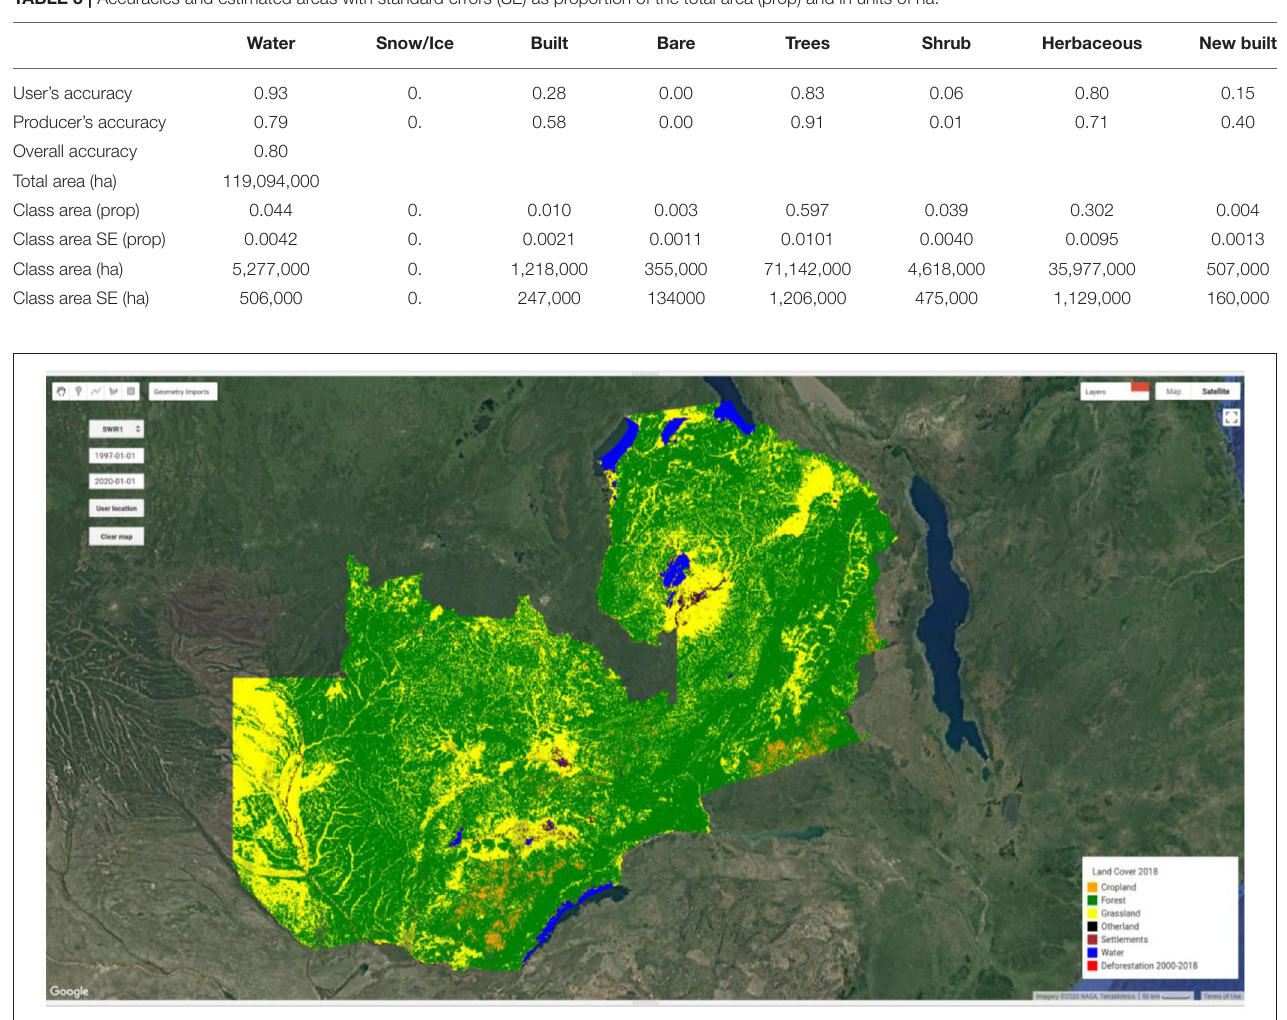
TABLE 3 | Accuracies and estimated areas with standard errors (SE) as proportion of the total area (prop) and in units of ha.